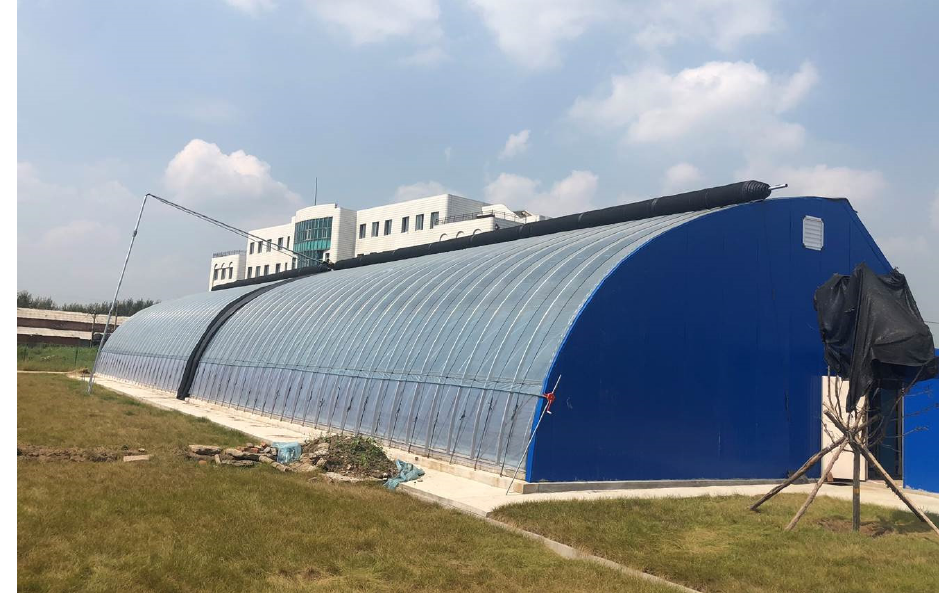
Figure 1. Schematic diagram of the mushroom solar greenhouse.